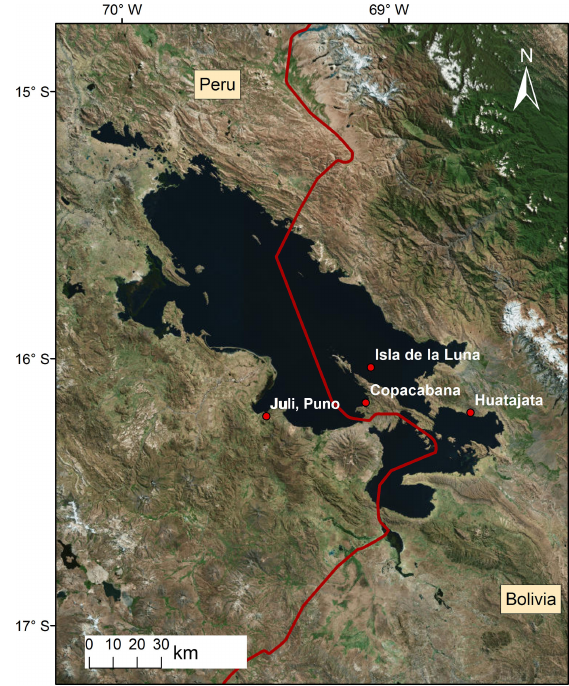
Figure 3. Location of observation points. Table 2. Monthly mean of hydrological variables observed